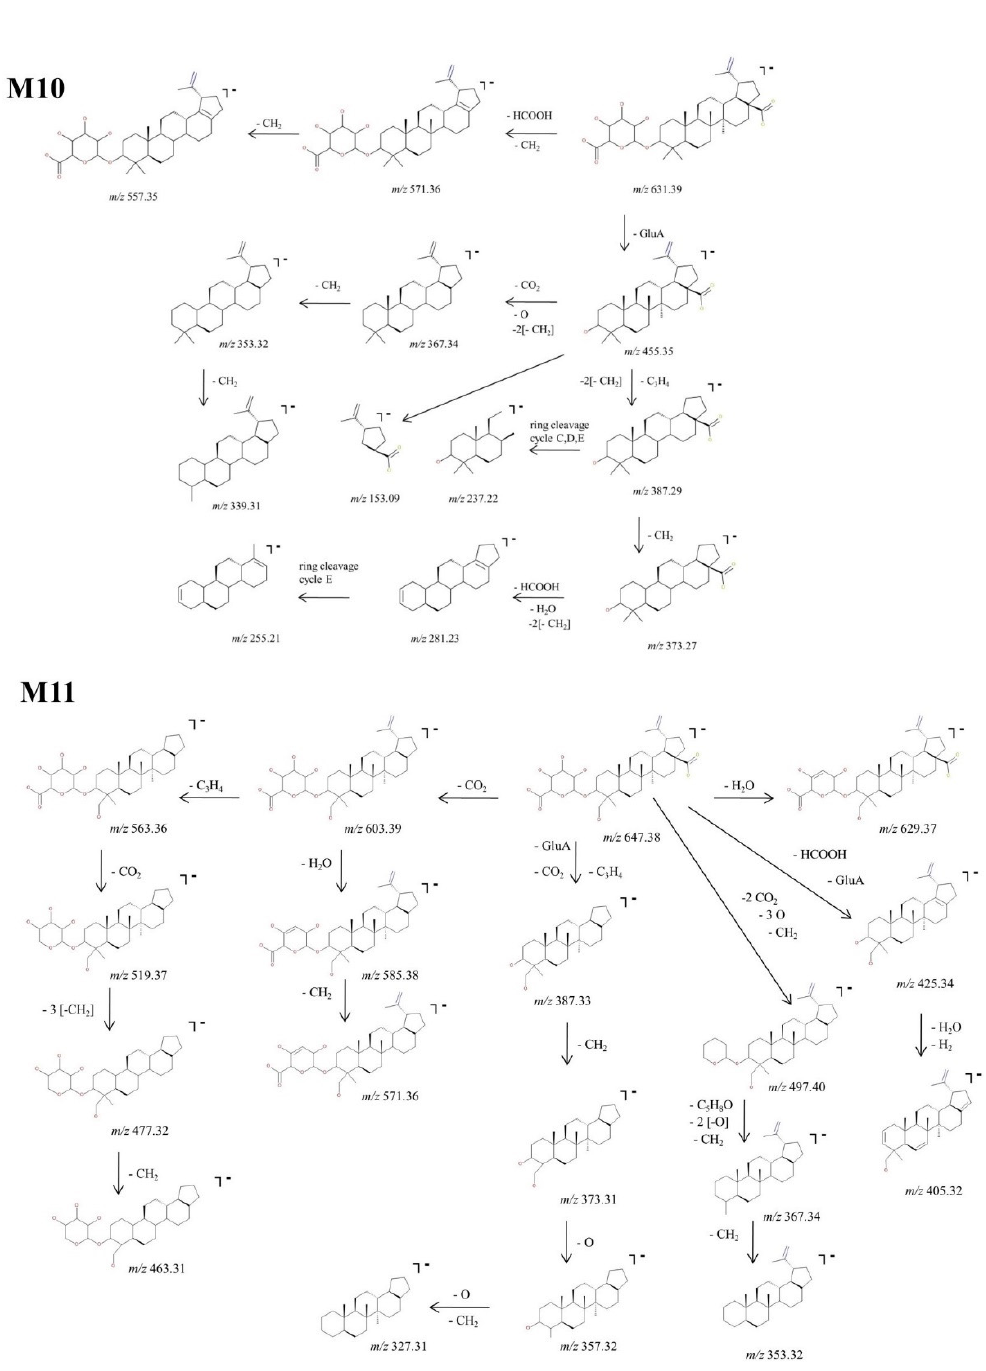
Figure 9. Proposed fragmentation pathway for phase II metabolites: M10–M11.